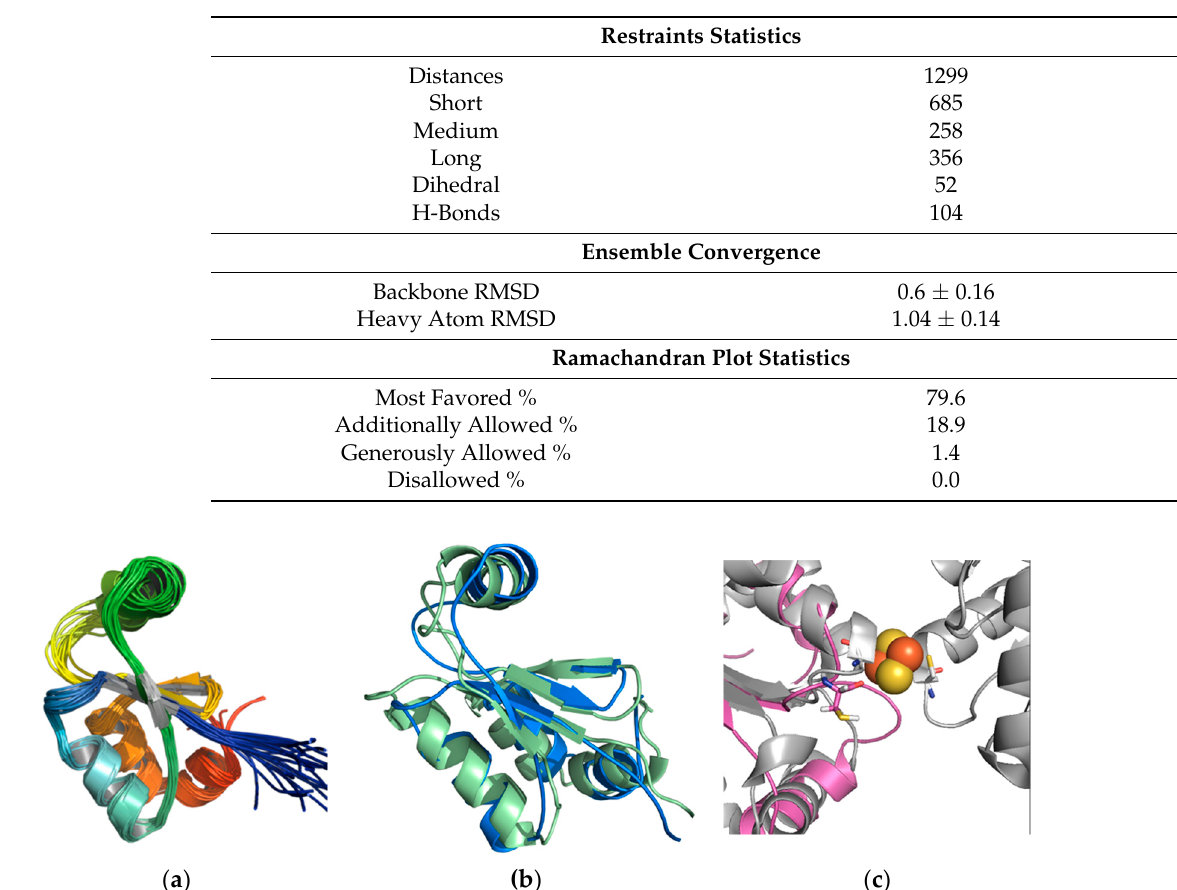
Table 2. NMR Statistics.